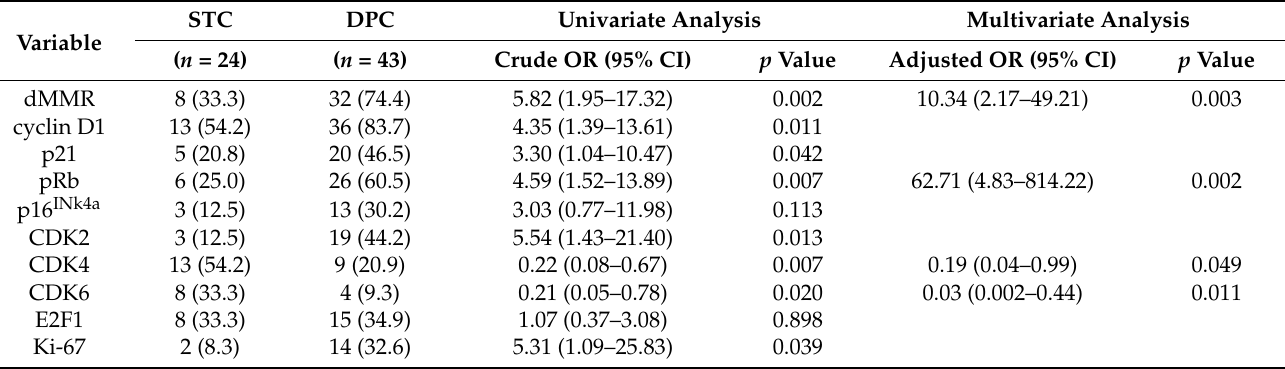
Table 2. Univariate and multivariate analysis of logistic regression between biomarkers and the status of STC/DPC. Univariate Analysis Multivariate Analysis Variable